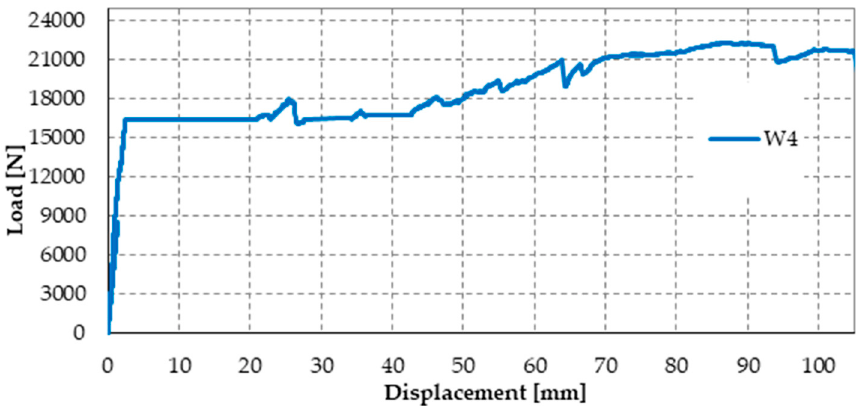
Figure 51. Load/displacement diagram of Specimen W4 in a flexural test performed in the load control.